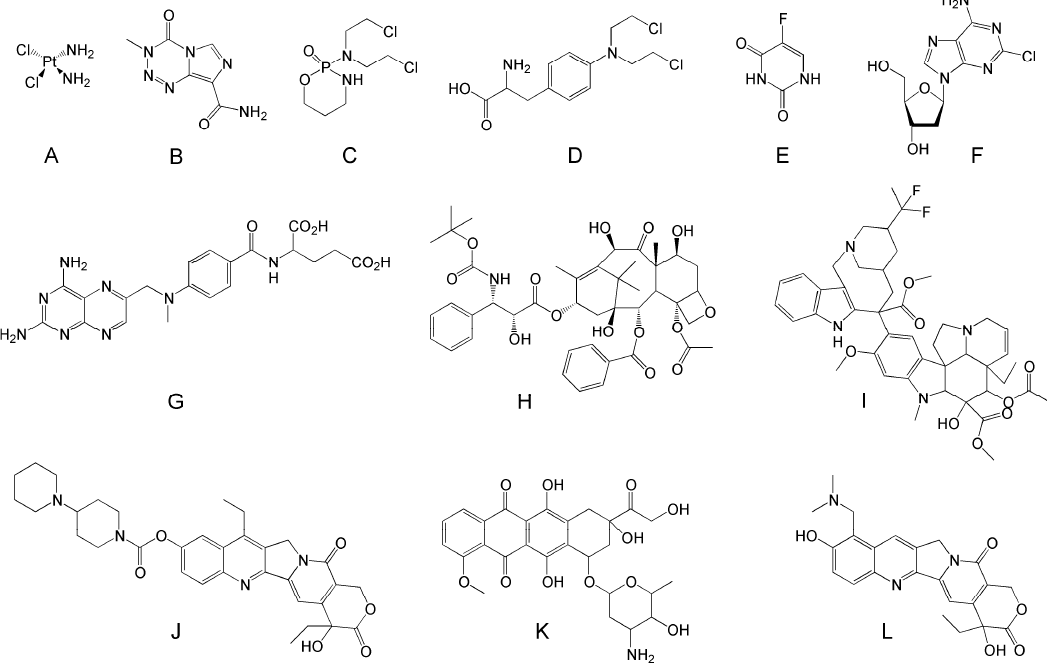
Figure 9. Chemical structures of anticancer drugs: ( A ) Cisplatin, ( B ) Temozolomide, ( C ) Cyclophosamide, ( D ) Melphalan, ( E ) Fluorouracil, ( F ) Cladribine, ( G ) Methotrexate, ( H ) Docetaxel, ( I ) Vinflunine, ( J ) Irinotecan, ( K ) Doxorubicin, and ( L ) Topotecan. Telodendrimers in Drug Combination Therapy